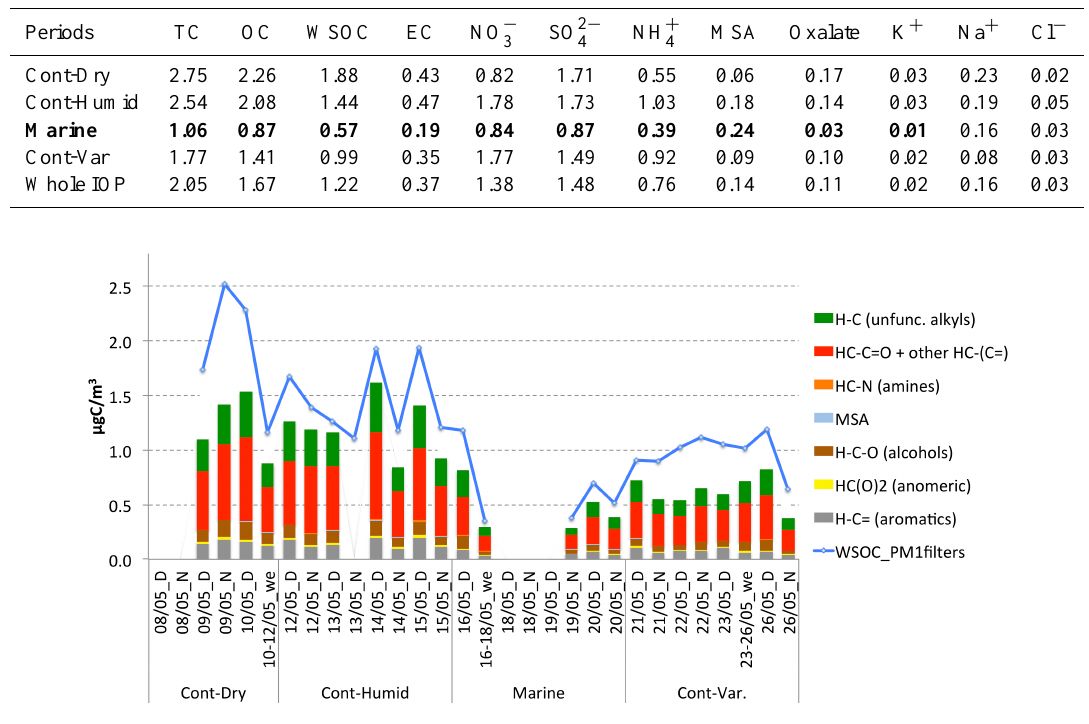
Fig. 3. Functional groups composition of PM 1 filter samples by NMR